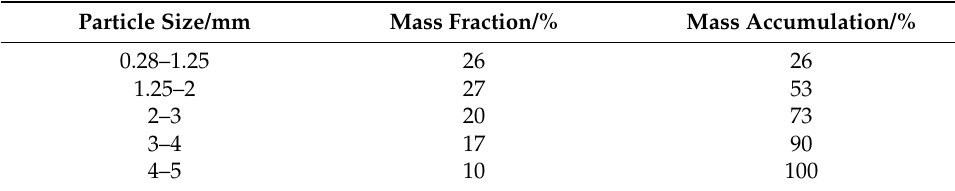
Table 2. Physical properties of test materials.